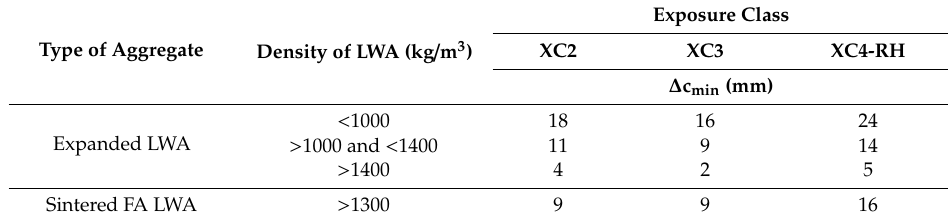
Table 5. Additional concrete cover in SLWAC ( ∆ c min ) relative to the minimum concrete cover defined in EN 1992-1-1 [18], for intended design service life of 50 years under carbonation-induced